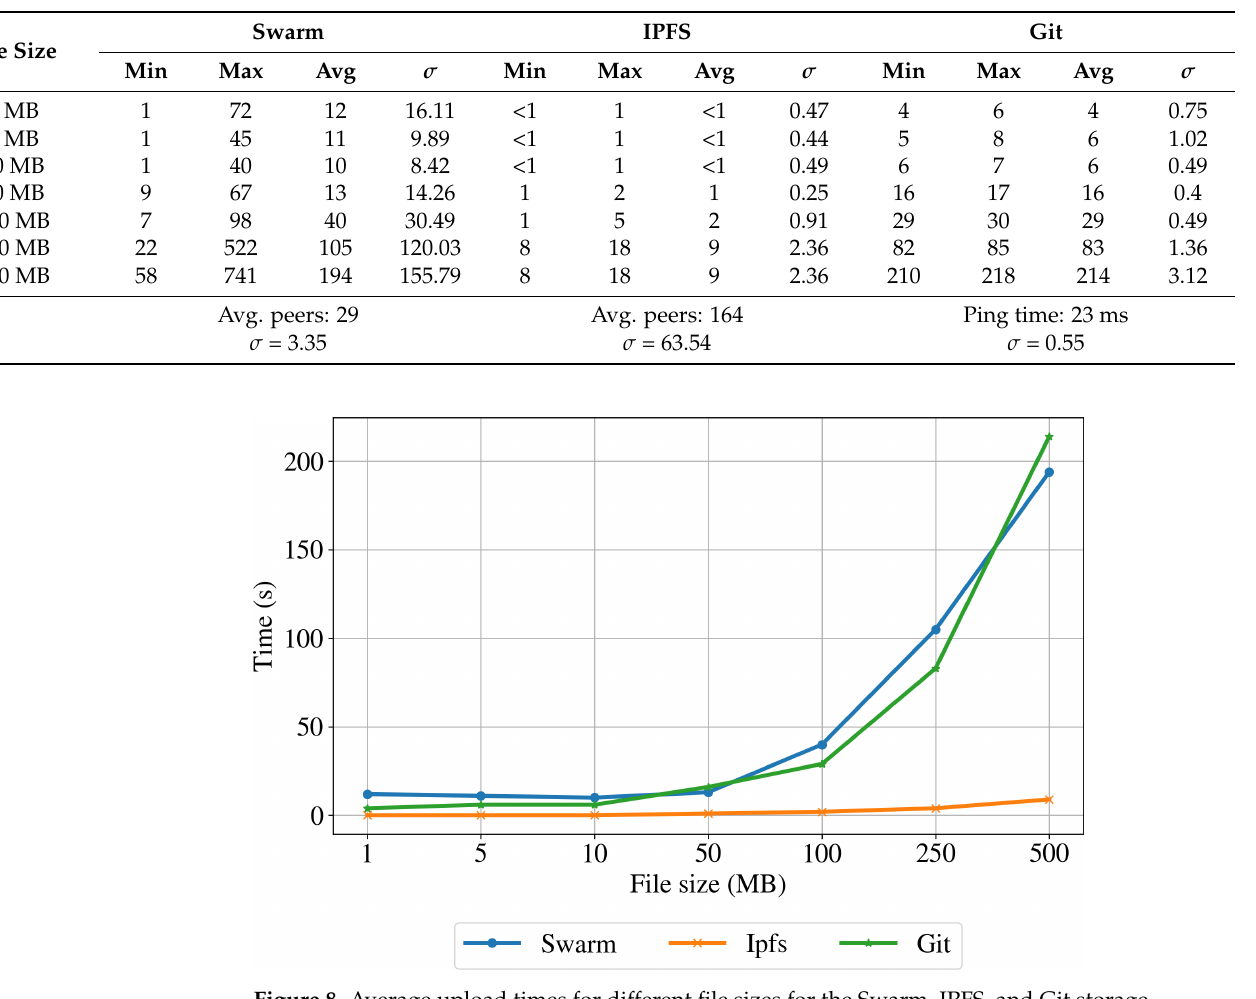
Figure 8. Average upload times for different file sizes for the Swarm, IPFS, and Git storage. Dataset download time. To assess the performance of the proposed architecture